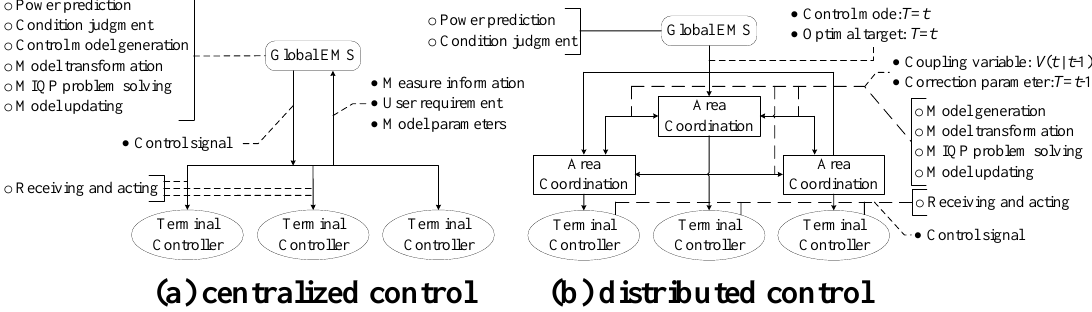
Figure 11. Comparison of centralized and distributed ADN load control in underpowered condition; ( a ) centralized control; ( b ) distributed control. Difference (1): Control structure. The centralized control only has two control levels, global EMS and terminal controller, and all the information is exchanged between these two levels. The